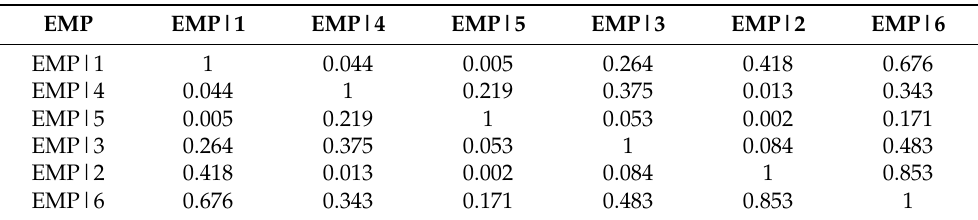
Table 7. p -Values between number of employees and extent of the ethical code after Bonferroni- corrected significance level: 0.0033.